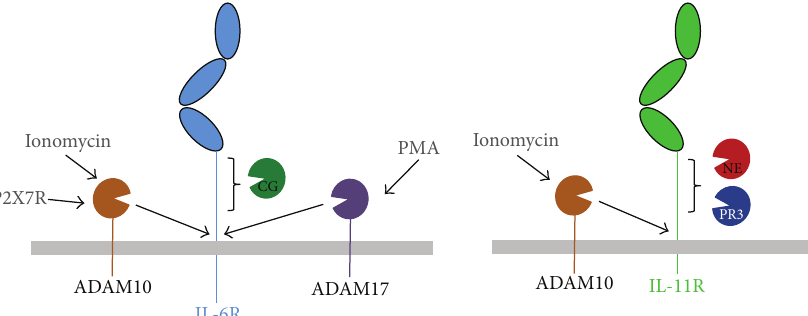
Figure 2: Proteolytic cleavage of the IL-6R and the IL-11R. The IL-6R is a substrate for ADAM10 (activated by ionomycin or via stimulation of the P2X7R), ADAM17 (activated, e.g., via the phorbol ester PMA), or the NSP cathepsin G (CG). The cleavage sites of ADAM10 and ADAM17 are located close to the plasma membrane. CG appears to cleave further upstream, but the exact cleavage site is not known. In contrast, the IL-11R can be cleaved by ADAM10 and the two NSPs neutrophil elastase (NE) and proteinase 3 (PR3). The exact cleavage sites have not been determined so